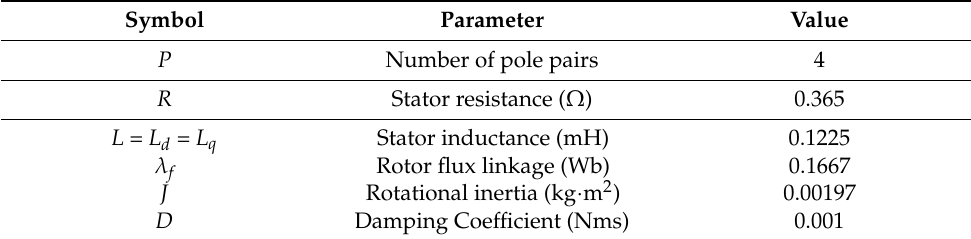
Table 1. Parameters of the